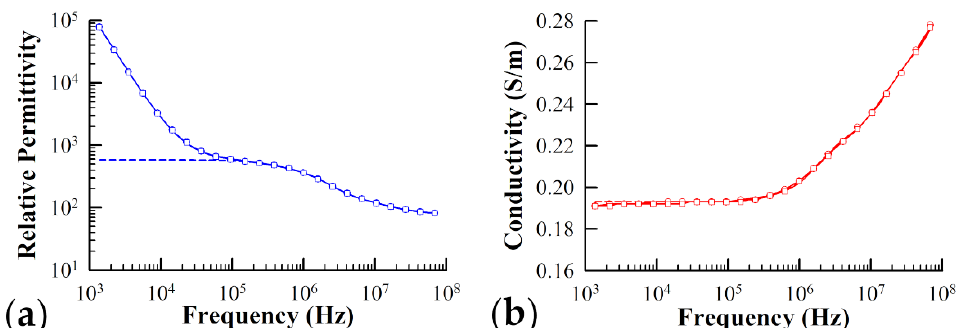
Table 3. Average difference between electrical phase parameters, plus or minus one standard de- viation, (n = 4 experiments) along with the p -value obtained by applying a paired Student’s t -test to pairs of Ste2 Δ cell suspensions suspended in electrolytic solution with and without Sorbitol added to it.